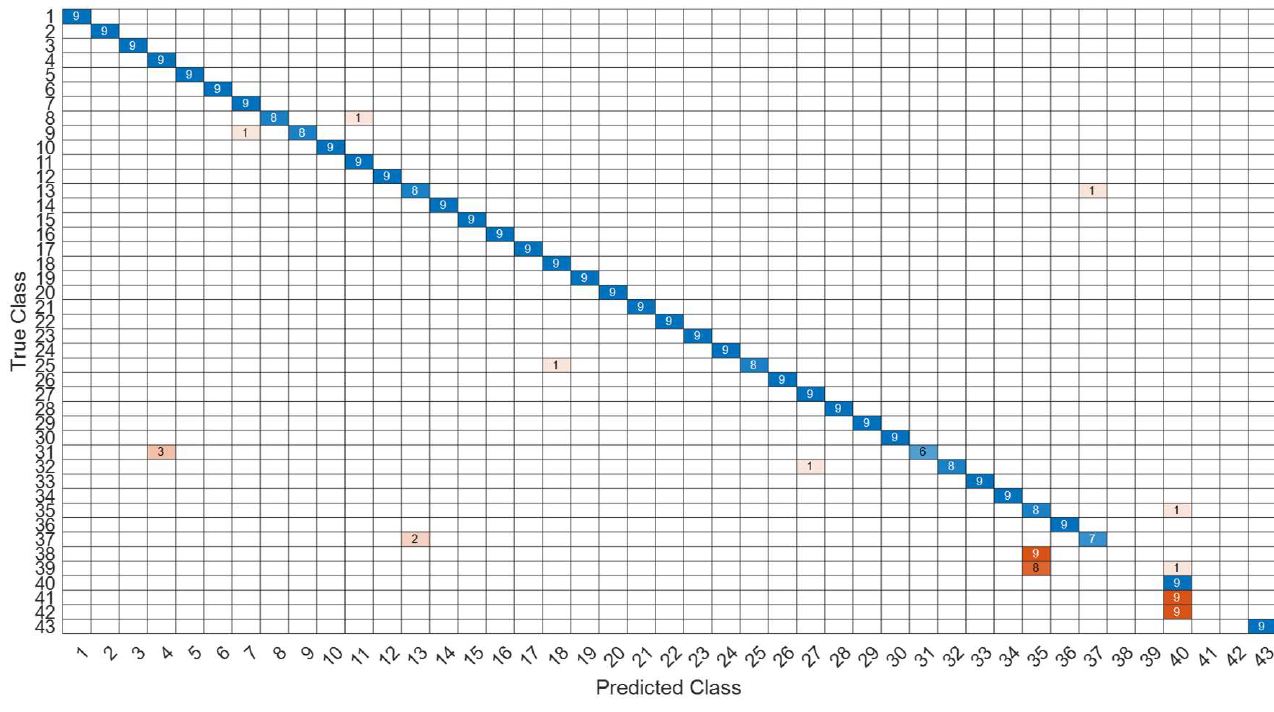
Figure 24. The confusion matrix of the CNN model with wavelet 30-features dataset.